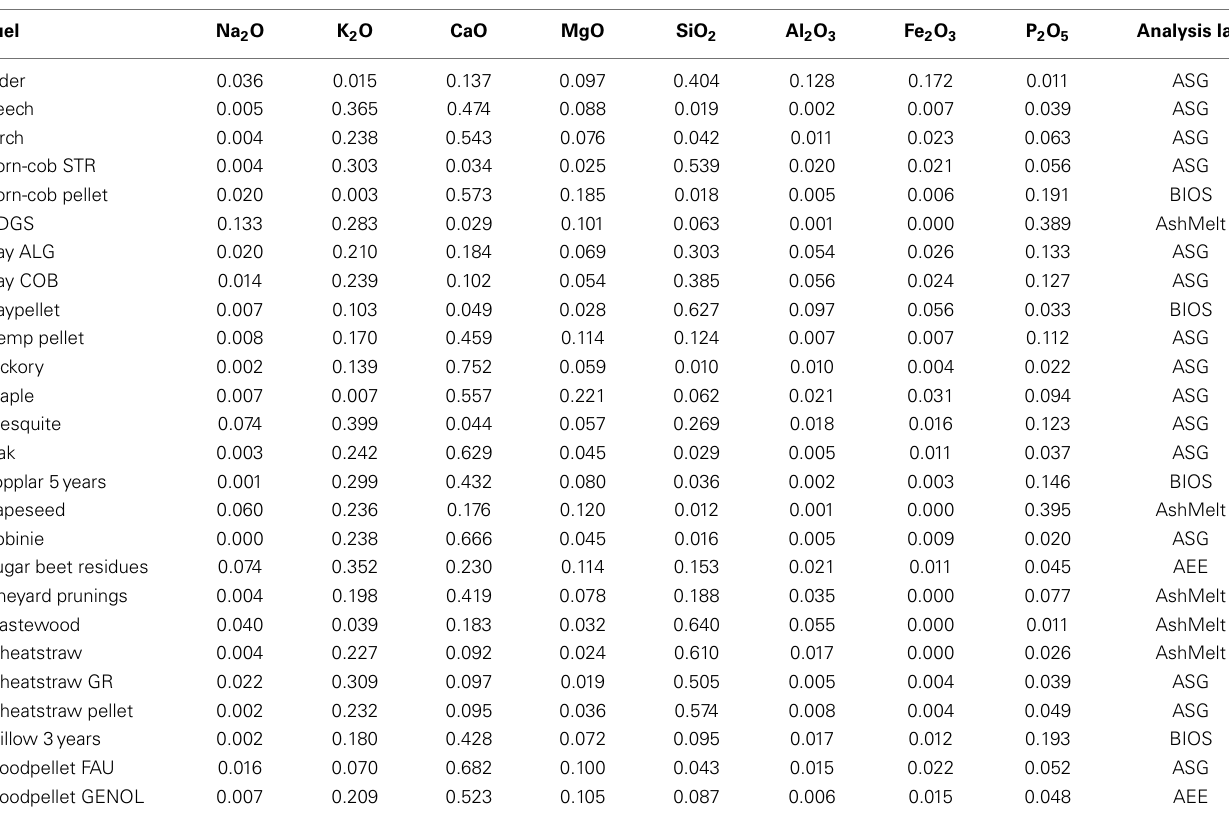
Table 3 | Composition of the tested biomass ashes (kg/kg ash ) .